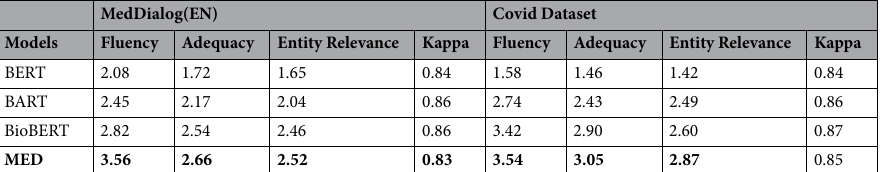
Table 7. Human assessment results for the baseline and proposed model on the MedDialog(EN) and Covid dataset. The bolded values represent the best value for each